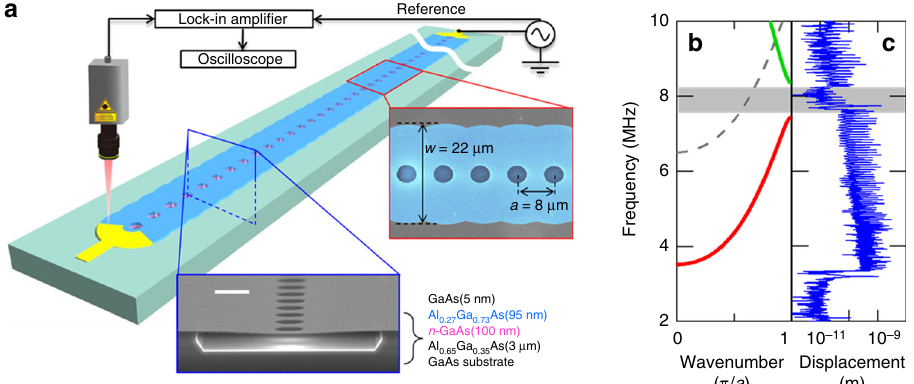
Fig. 1 1D phononic crystal waveguide. a A schematic of the PnC WG and the measurement setup. The bottom inset shows SEM image of the cross-section of the device which is composed of a GaAs/AlGaAs heterostructure fabricated by selectively etching the Al 0.65 Ga 0.35 As layer, scale bar is 5 μ m. The periodic structures are determined by the WG width of 22 μ m and the hole pitch of 8 μ m as shown in the right inset (false colored SEM image). The nanomechanical vibrations are piezoelectrically excited at the right edge and detected at the left edge with a laser Doppler interferometer at room temperature and in a high vacuum (2 × 10 − 4 Pa). b The FEM simulated dispersion relation of the PnC WG. The internal stress between the GaAs and Al 0.27 Ga 0.73 As layers is included in the simulation 34 . The dashed line indicates the second phonon band, which does not contribute to the transmission due to the piezoelectric transducer electrodes being located at the nodal position of the mode in this band. c The experimental transmission spectrum, which is measured at the left edge by employing continuous excitation with 1.0 V rms from the right